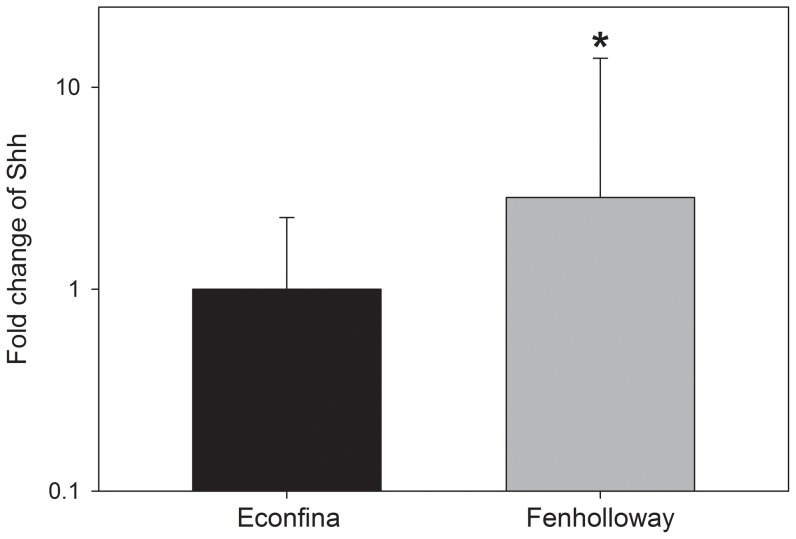
Anal fin gene expression patterns of sonic hedgehog (shh) in female Eastern mosquitofish (G. holbrooki).An asterisk indicates statistical significance between the paper mill exposed (Fenholloway) and reference (Econfina) rivers as determined using a Student's t-test with p<0.05.